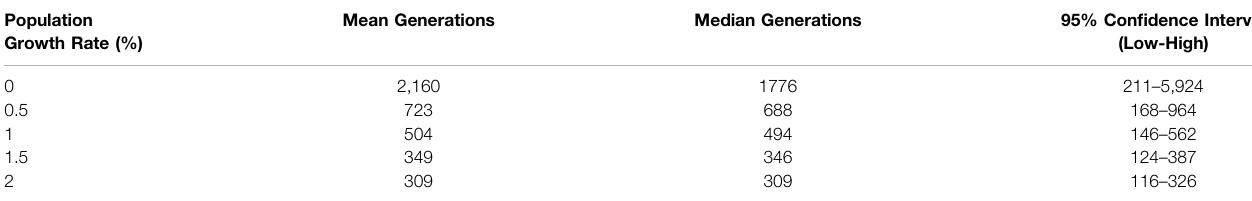
TABLE 3 | Summary of DMLE mutation age estimates for different population growth rates and their con fi dence intervals. Population Growth Rate (%)